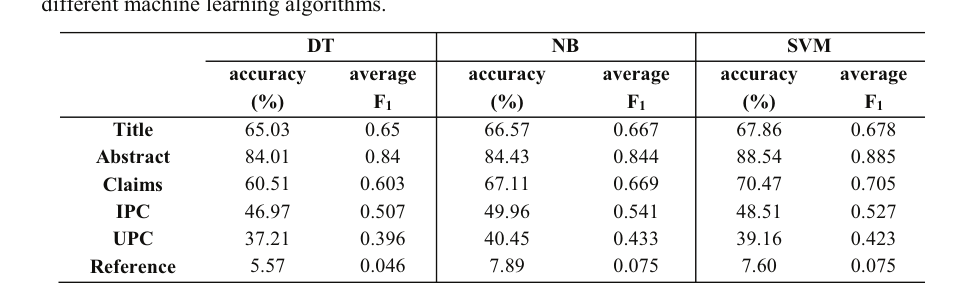
Table 3. Classification performances based on single sections of a patent document using three different machine learning